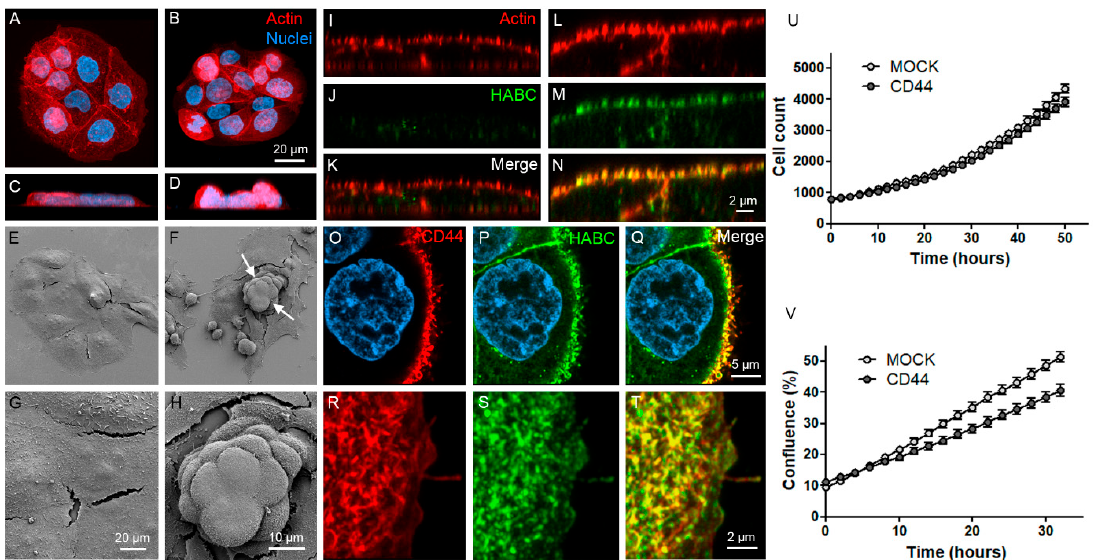
Figure 3. Morphology of MKN74 cells as analyzed by confocal and scanning electron microscopy. Maximum intensity projections created from stacks of confocal optical sections ( A , B ) and side views ( C , D ) of live MKN74 MOCK ( A , C ) and CD44-expressing ( B , D ) cells stained with Alexa Fluor 594-labeled phalloidin (red) to label the actin cytoskeleton. Scanning electron microscopy of MOCK ( E , G ) and CD44 ( F , H ) cultures with low ( E , F ) and high ( G , H ) magnification. Superresolution orthogonal sections of MOCK ( I – K ) and CD44 ( L – N ) cells double-stained with actin ( I , L ) and HA ( J , M ). Merged images are shown in ( K , N ). Superresolution sections of CD44-positive cells double-stained with CD44 ( O ) and bHABC ( P ) and maximum intensity projections from the surface of the same cell with CD44 ( R ) and bHABC ( S ). Merged images from ( O , P ) and ( R , S ) are shown in ( Q , T ), correspondingly. Incucyte live cell analysis of proliferation rate ( U ) and confluency ( V ) of the cells. Data are representative of 3 independent experiments. The means ± S.E of 4 replicates are shown in ( U , V ).